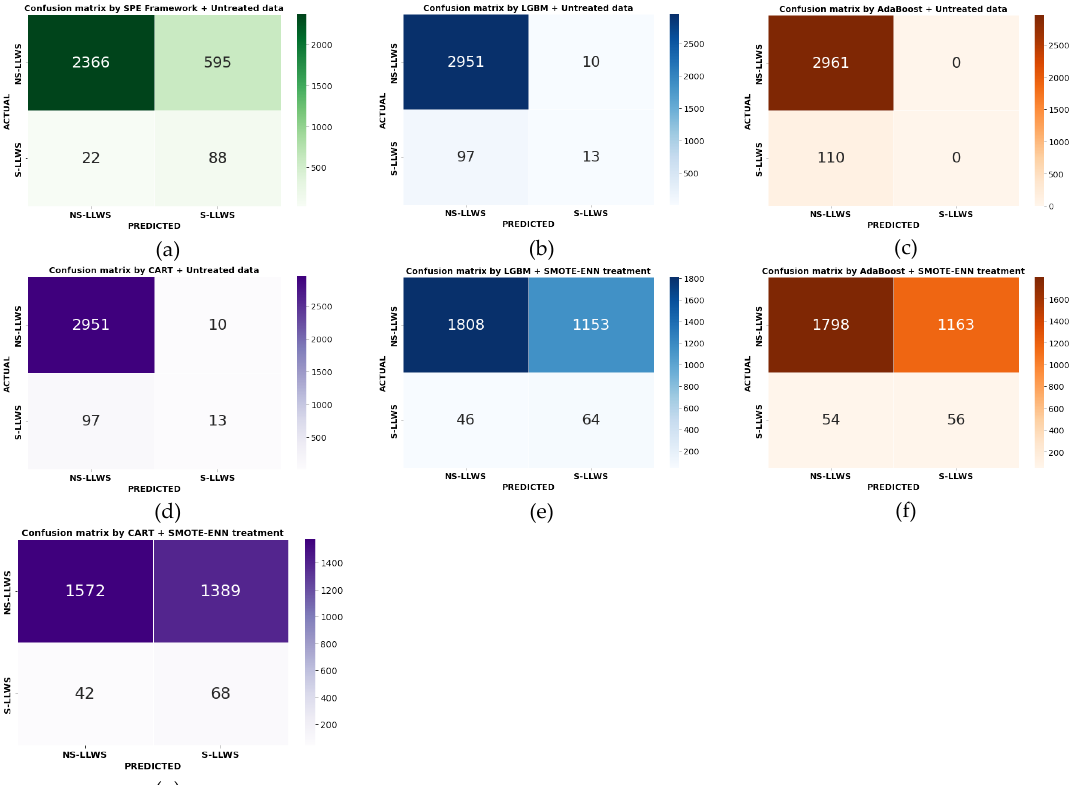
Figure 7. Confusion Matrix: ( a ) SPE framework, ( b ) LGBM without data treatment, ( c ) AdaBoost without data treatment, ( d ) CART without data treatment, ( e ) LGBM with SMOTE-ENN data treatment, ( f ) AdaBoost with SMOTE-ENN data treatment, ( g ) CART with SMOTE-ENN data treatment. Table 3. Performance measure of machine learning models.